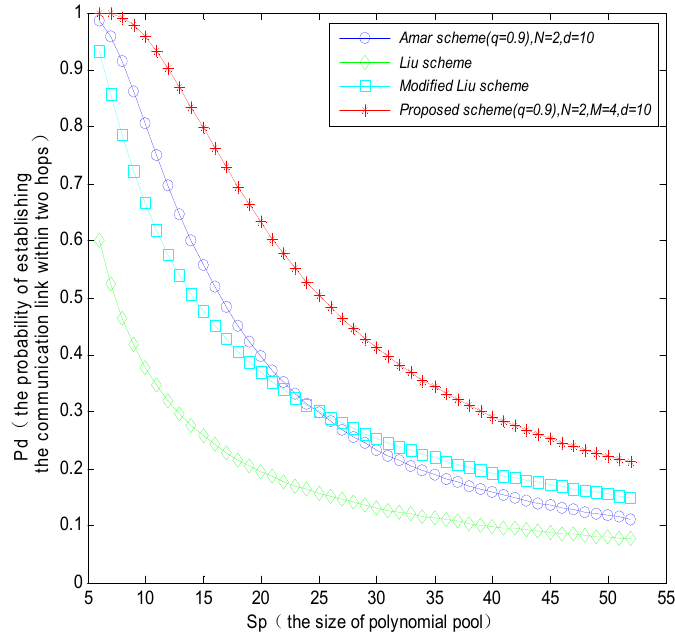
Figure 8. The probability that a MS and sensor nodes establish a communication link within two hops when the number of neighbor nodes d = 10.